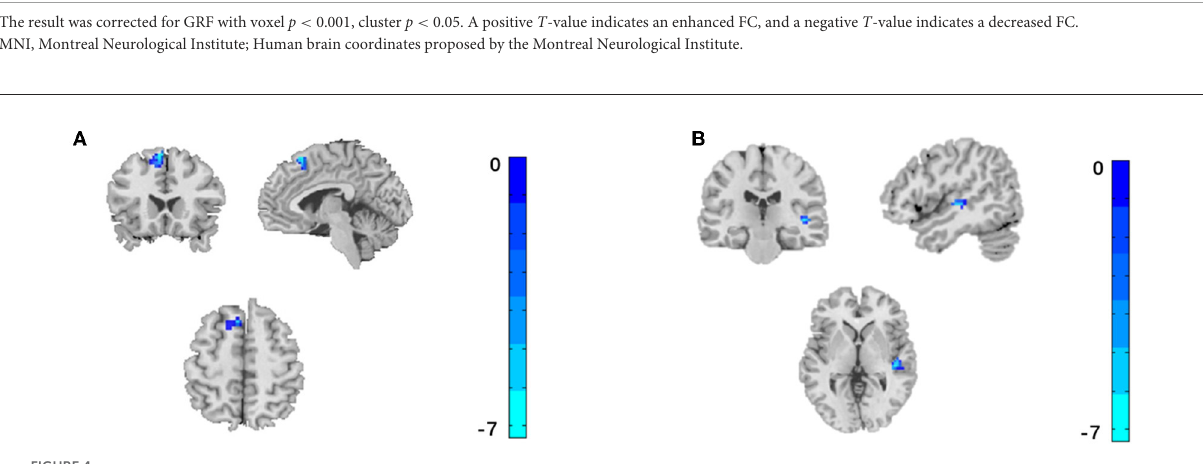
Thirdly, data were co-registered with the structural images, spatial normalized to the Montreal Neurological Institute (MNI) template, and voxels were re-sampled to 3 × 3 × 3 mm 3 resolution. Finally, data were spatially smoothed with a 6-mm full width at half-maximum (FWHM) Gaussian kernel, and detrended and filtered (0.01-0.08